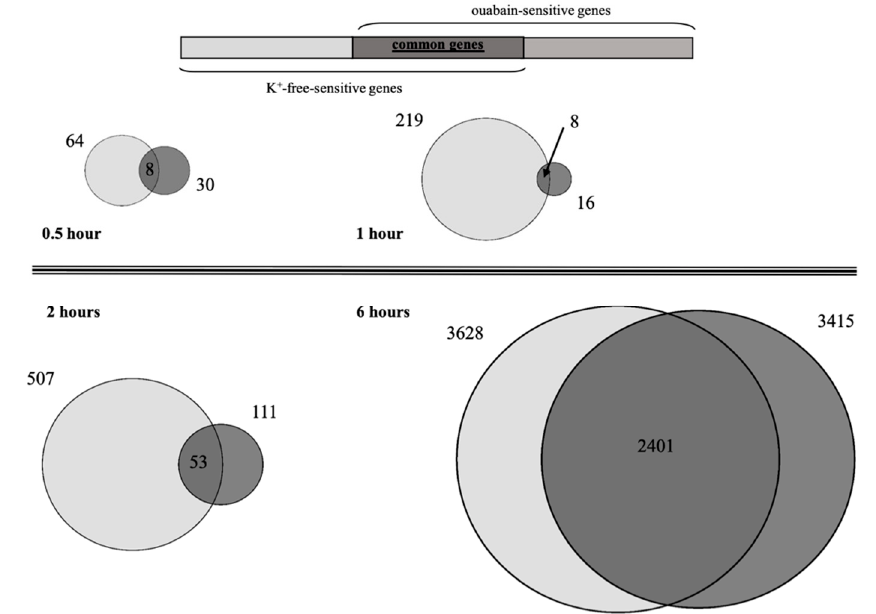
Figure 3. Venn diagram representing the distribution of common differentially expressed genes identified in HUVEC exposed to 3 μ M ouabain, or subjected to K + -free medium, vs. control samples in 0.5, 1, 2, and 6 h. The number of common differentially expressed genes are shown within overlapping areas. The total number of upregulated and downregulated genes identified in ouabain- or K + -free medium-treated cells is shown in Table 1.